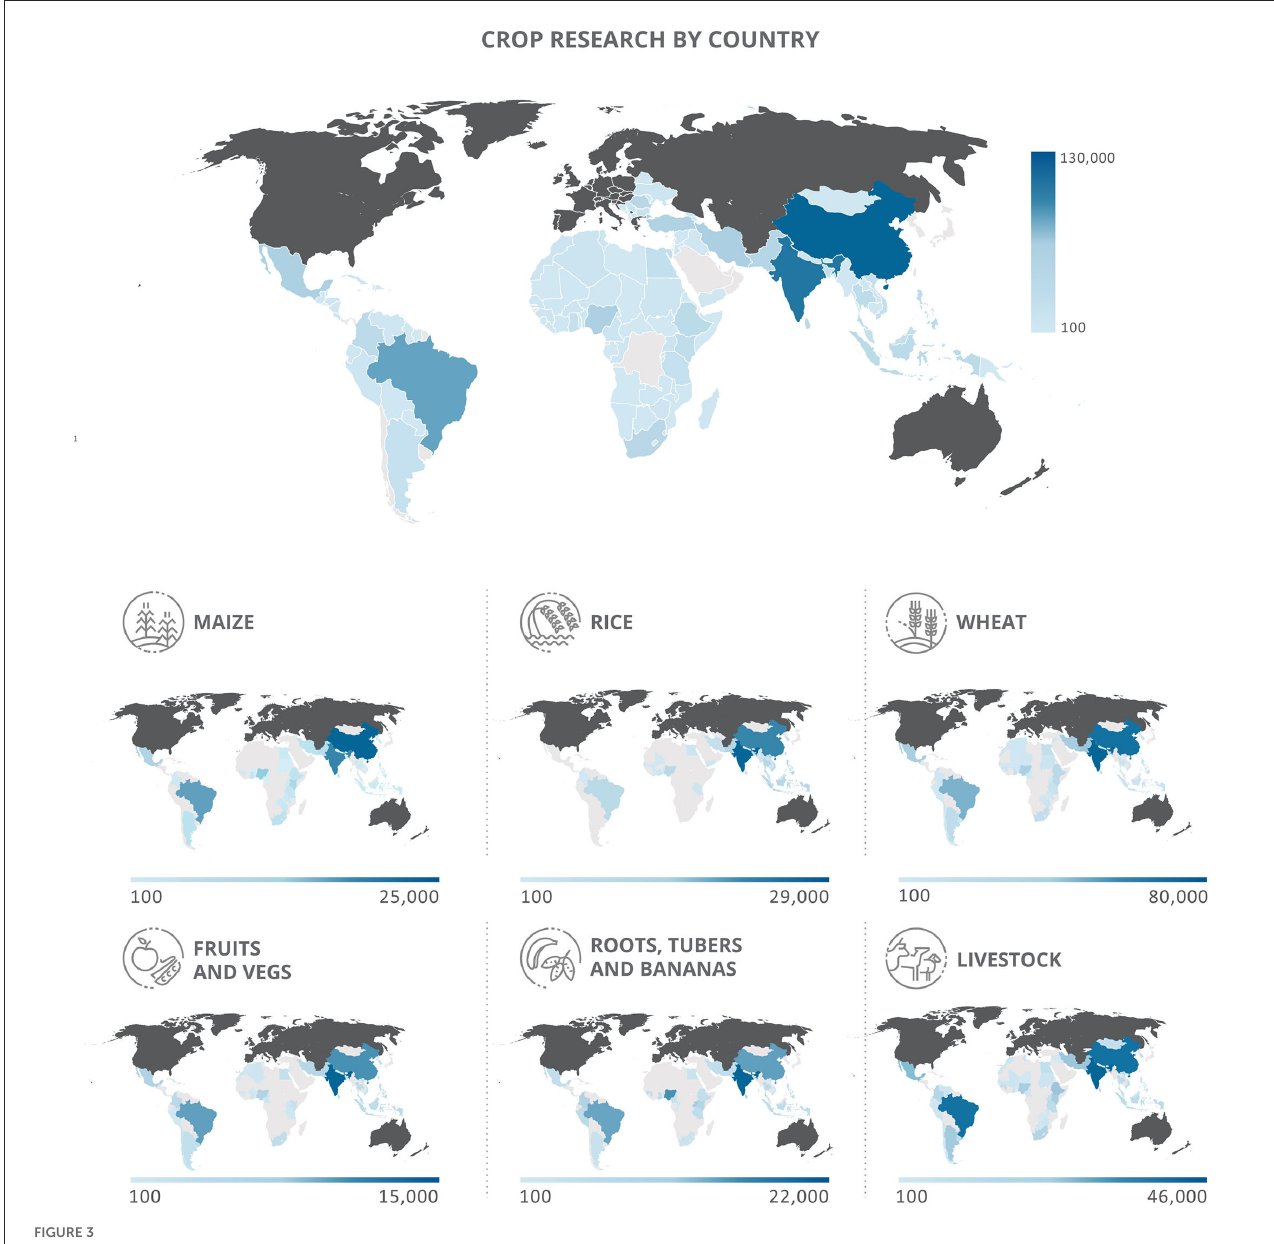
FIGURE3 A country-level look at research production across specific crops.